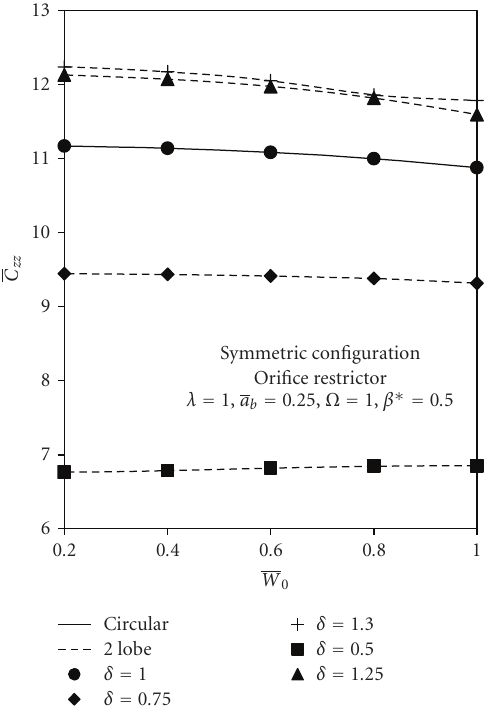
Figure 12: Variation of direct damping ( C zz ).